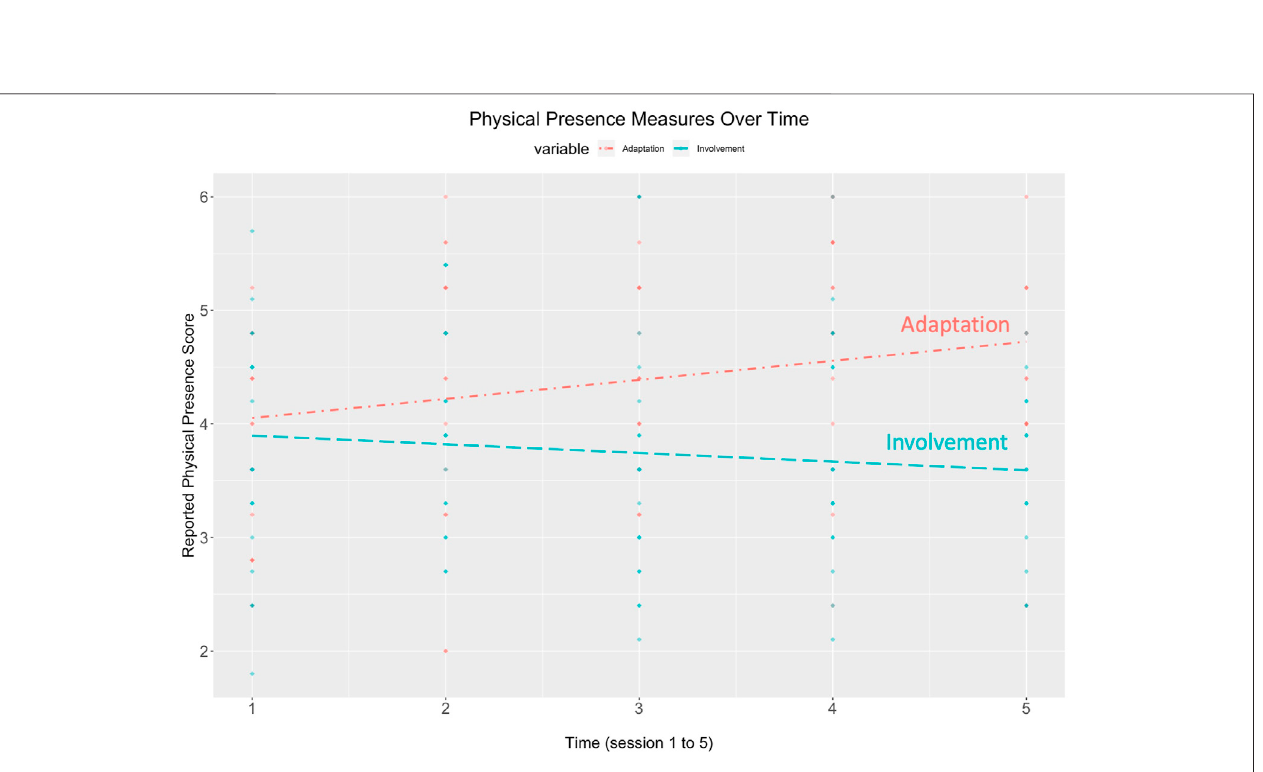
Frontiers in Virtual Reality |